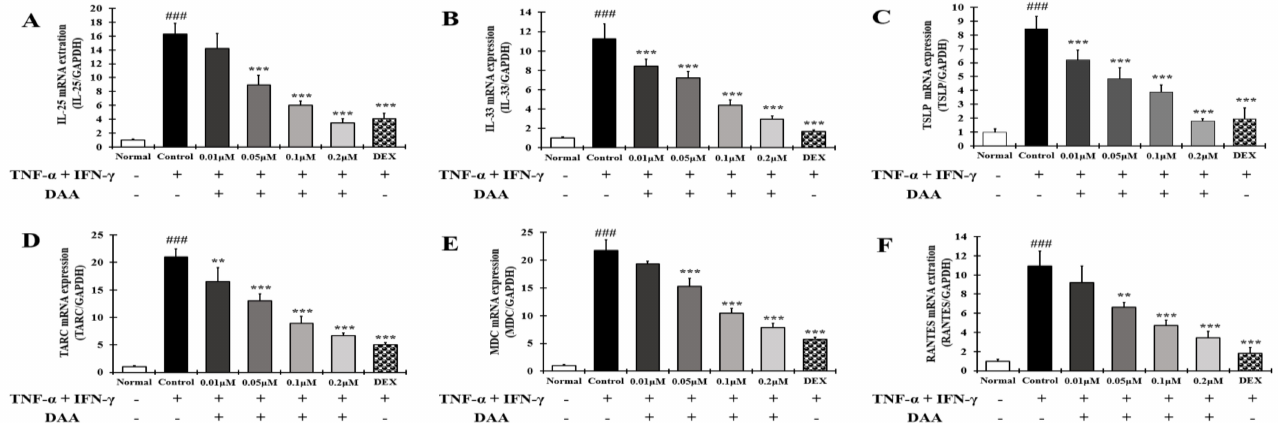
Figure 8. Effect of DAA on the gene expression levels of AD-related cytokines and chemokines involved in Th2 cell activity in HaCaT cells. The gene expression levels of IL-25 ( A ), IL-33 ( B ), TSLP ( C ), TARC ( D ), MDC ( E ), and RANTES ( F ) are shown. Total RNA was isolated from HaCaT cells and analyzed by RT-qPCR. The expression levels were normalized to that of GAPDH. The results are expressed as the mean ± SD (n = 4). ### p < 0.001 vs. normal; ** p < 0.01 and *** p < 0.001 vs. control; DAA was used at 0.01 µ M, 0.05 µ M, 0.1 µ M, and 0.2 µ M. DEX, the positive control, was used at 0.1 µ